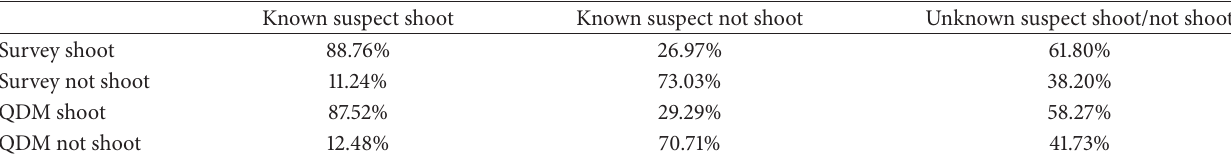
Table 8: The Game Theory prediction, survey result, and experiment results using QDM on A Sheriff’s Dilemma. Known suspect shoot Known suspect not